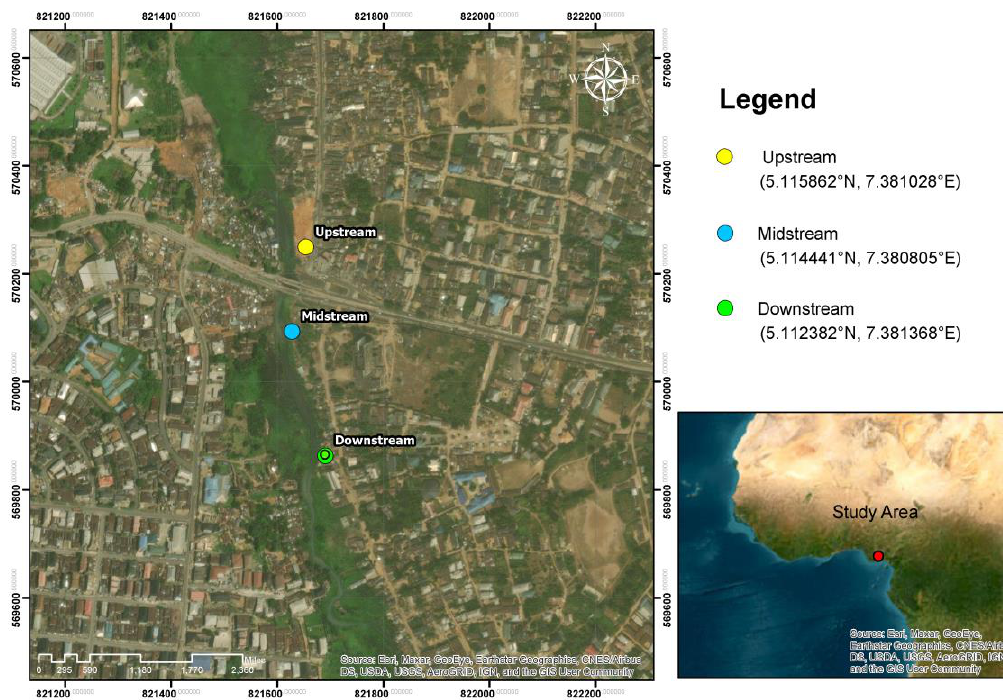
Figure 1. The study location and hotspot for sampling in Ogbor Hill River, Nigeria.